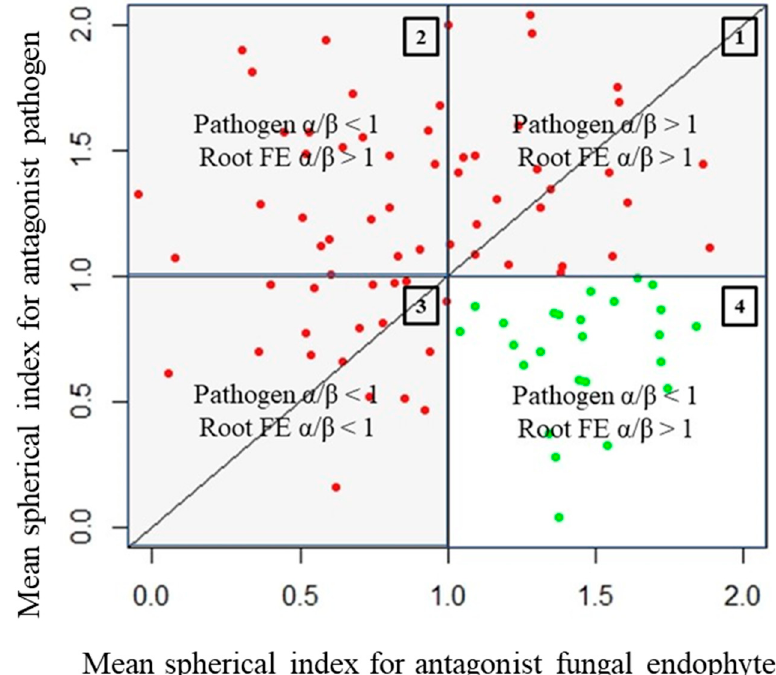
Figure 3. A graph of the mean spherical indices of a set of root fungal endophyte (FE) antagonists plotted against their single test pathogen. This is a simulated dataset generated from a random distribution ( n = 100, mean = 1, standard deviation = 0.5) that mimics empirical data observed in this experiment. In the graph above, the data points coloured green are non-spurious instances of successful antagonistic interaction while the red data points indicate spurious ones.